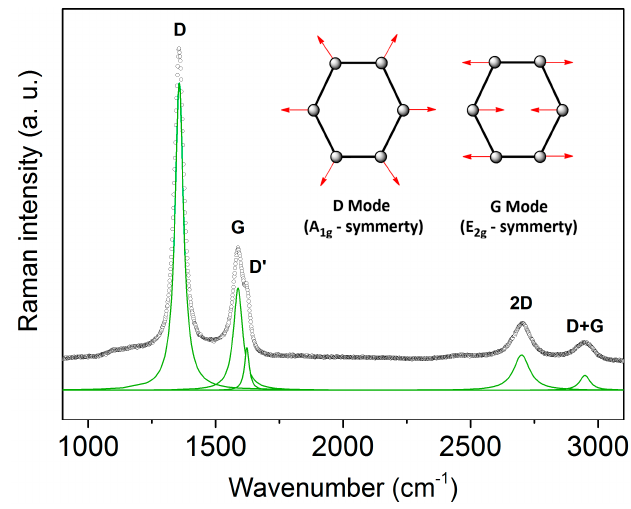
Figure 1. Room-temperature Raman spectrum of C-11. Green line: Lorentzian fits to the Raman modes. The inset shows the vibration modes of the D and G band.